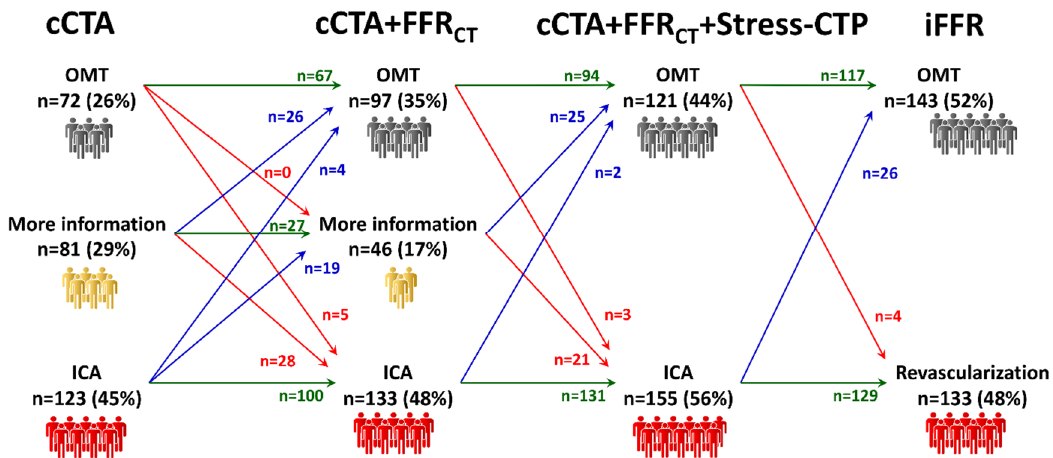
Figure 5. Management according to the sequential addition of FFR CT and Stress-CTP to